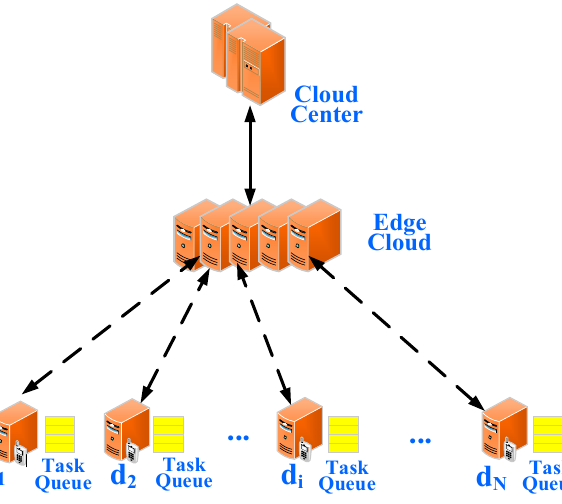
Figure 7. Edge computing model.